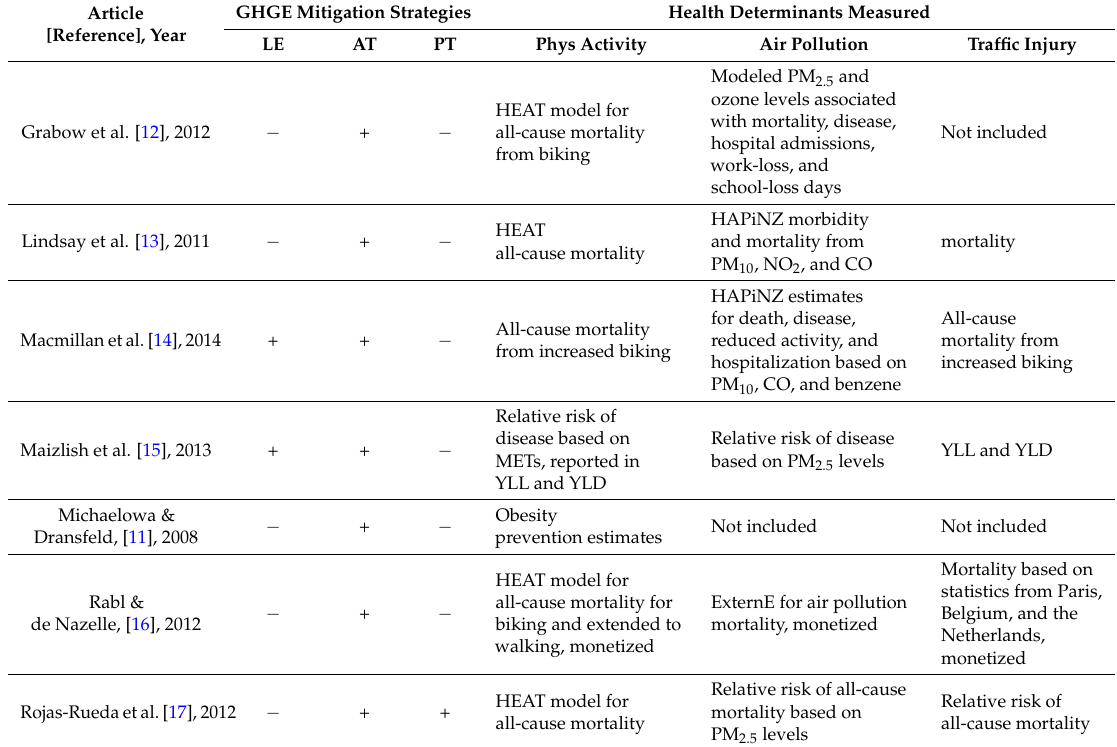
Table 3. Active Transport Articles—Mitigation Strategies and Health